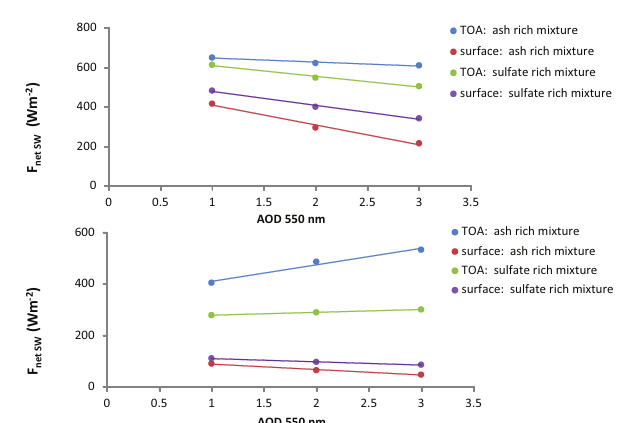
Fig. 11. The relationship between net SW flux and AOD(550nm) at an AOD range of 1–3 for two aerosol mixtures at the TOA and sur- face over seawater (top panel) and snow (bottom panel). SZA=55 ◦ . The R 2 regressions for all lines are greater than